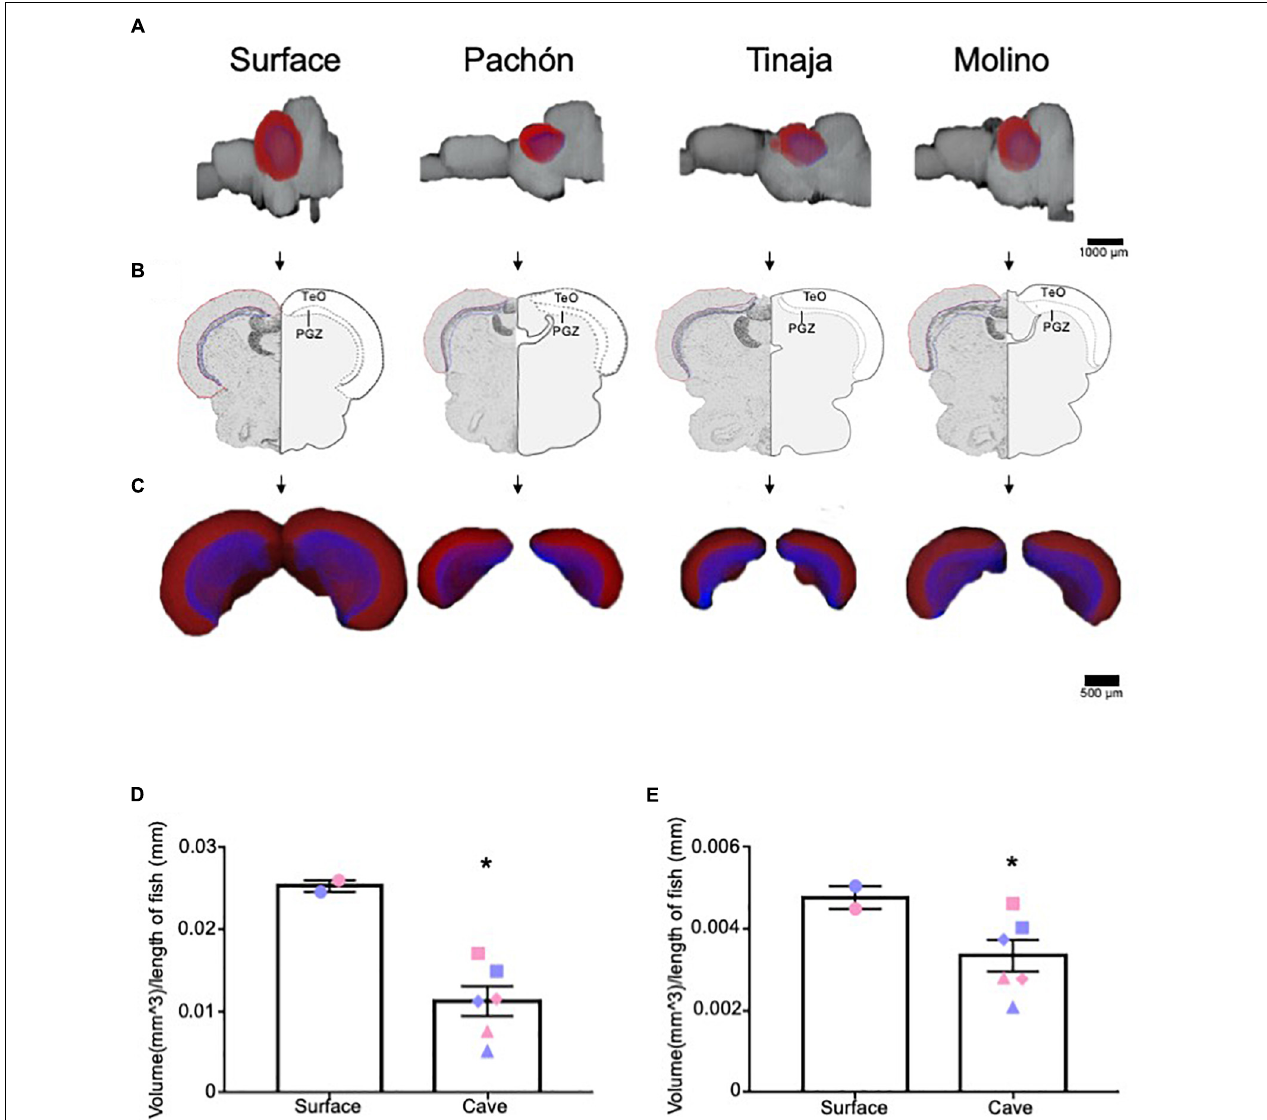
FIGURE 2 | Three-dimensional reconstruction reveals regression of the optic tectum. (A) 3-D reconstructions of Surface, Pachón, Tinaja and Molino with optic tectum (TeO; red) and periventricular gray zone of the optic tectum (PGZ; blue) displayed. (B) Images of sections that were Nissl stained (left), and a cartoon of the demarcated TeO and PGZ shown (right). (C) 3-D reconstruction of the TeO and PGZ. Displayed from an anterior view. (D) Quantification of the volume of optic tectum, normalized to the length of the animal for surface fish and for the three cave populations. Optic tectum of cavefish was significantly smaller than those of surface fish conspecifics (surface fish 0.025 ± 0.0007, cavefish 0.011 ± 0.0018, t -test t = 4.224, df = 6, p < 0.05). Quantification of the volume of PGZ. The PGZ of most cavefish was smaller than those of surface animals (surface fish 0.005 ± 0.0003, cavefish 0.003 ± 0.0004, t -test t = 1.987, df = 6, p < 0.05). Graphs in D and E are the mean ± standard error of the mean. Asterisk represent significance below p = 0.05. Blue shapes on bar graphs denote males, whereas light red shapes denote females. Squares on graphs represent Pachón, triangles represent Tinaja and diamonds represent Molino.